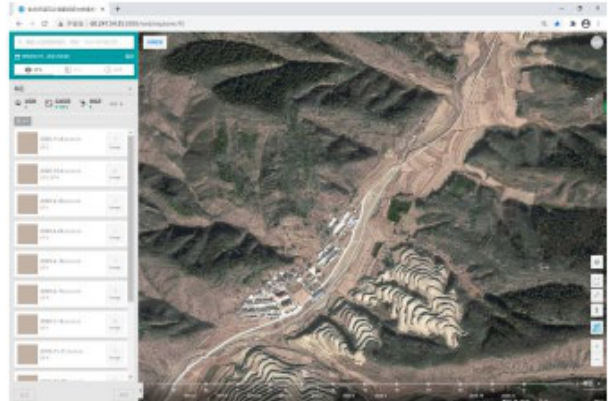
Figure 8. The platform for real-time service of dynamic